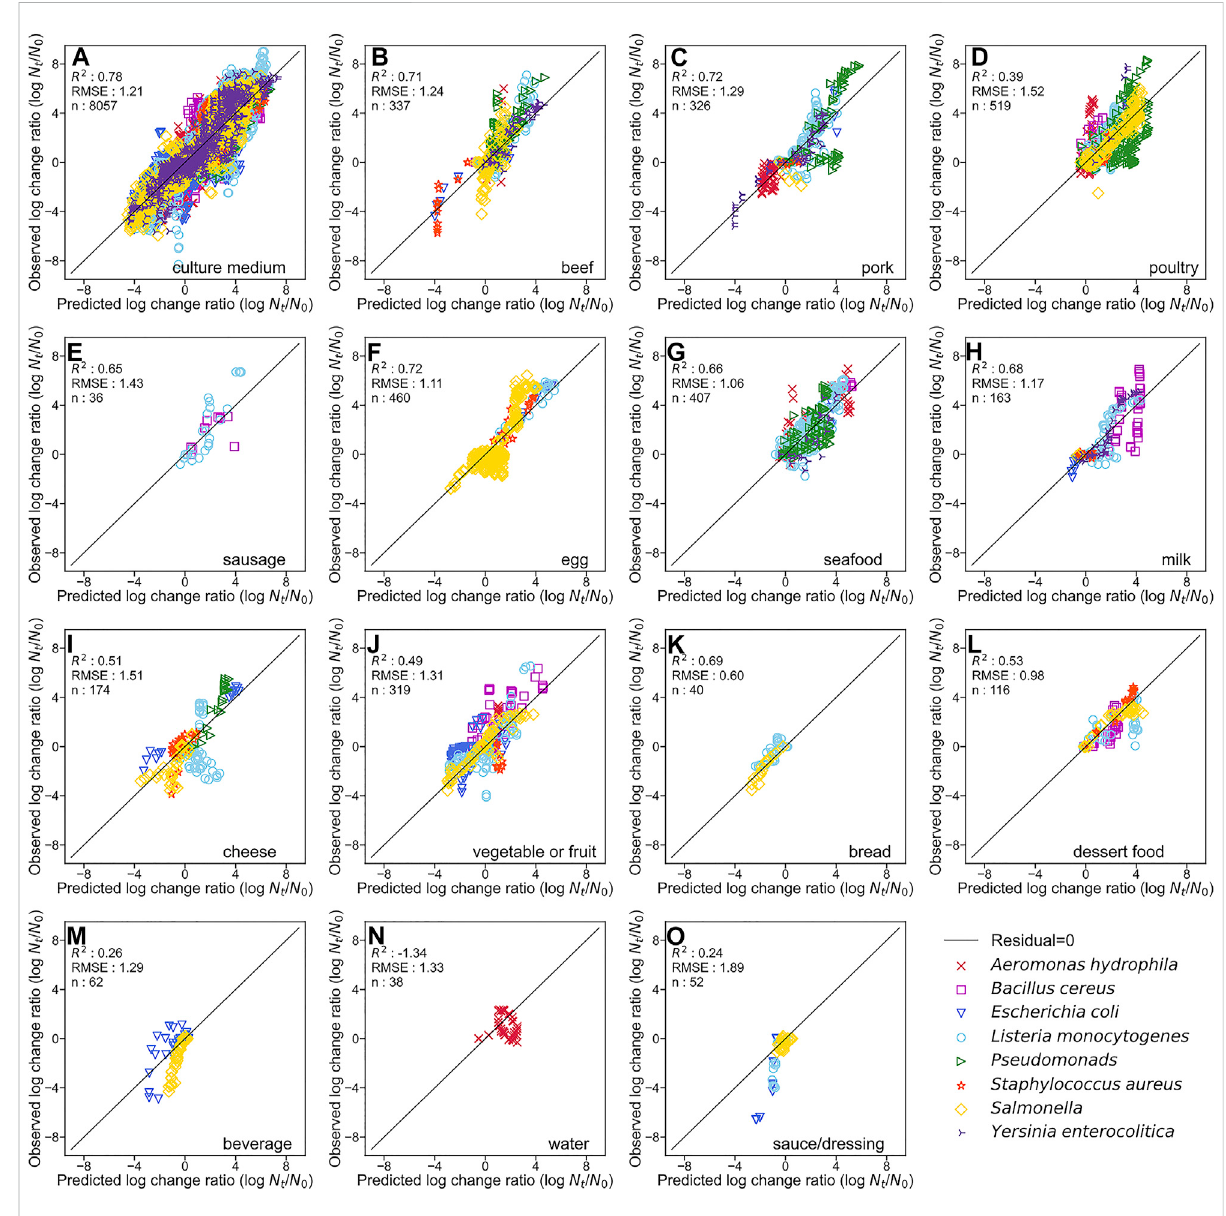
FIGURE 3 Comparison of the predicted and observed log change ratio for test data of culture medium (A) , beef (B) , pork (C) , poultry (D) , sausage (E) , egg (F) , seafood (G) , milk (H) , cheese (I) , vegetable or fruit (J) , bread (K) , dessert food (L), beverage (M) , water (N) , and sauce/dressing (O) . The solid line represents residuals =